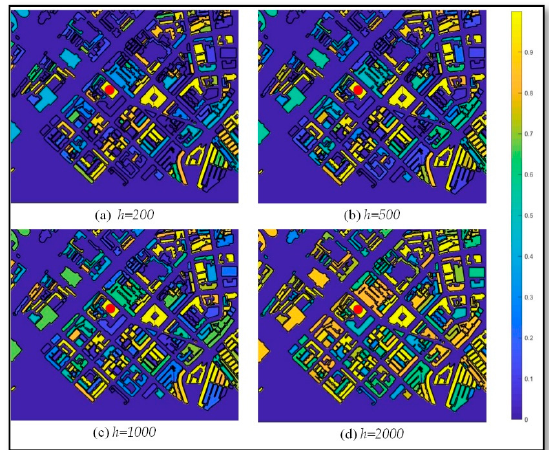
Figure 4. Environmental similarity of buildings. Figure 4a shows the spatial distribution of household density in the study area and crime cases marked with red dots. Figure 4b shows the spatial distribution of household density similarity between a building marked with red dot and the surrounding buildings with yellow and blue indicating high and low similarity, respectively. The similarity is clearly low regarding